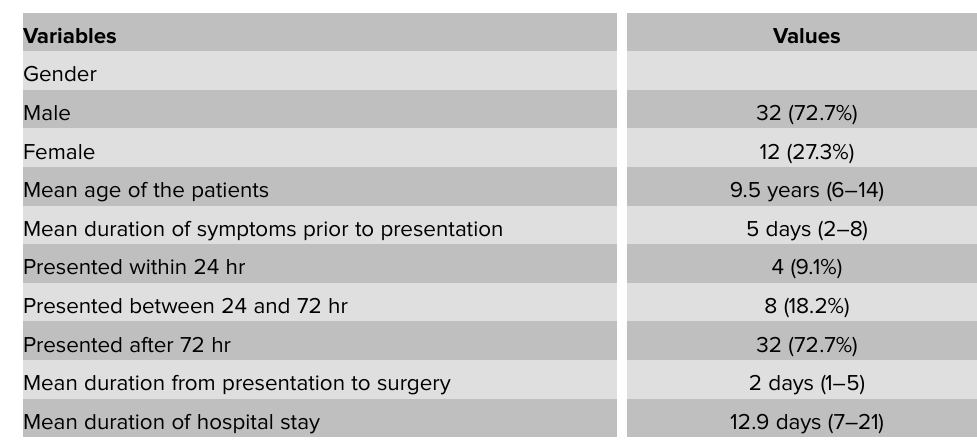
TABLE 1: Patients’ demography.